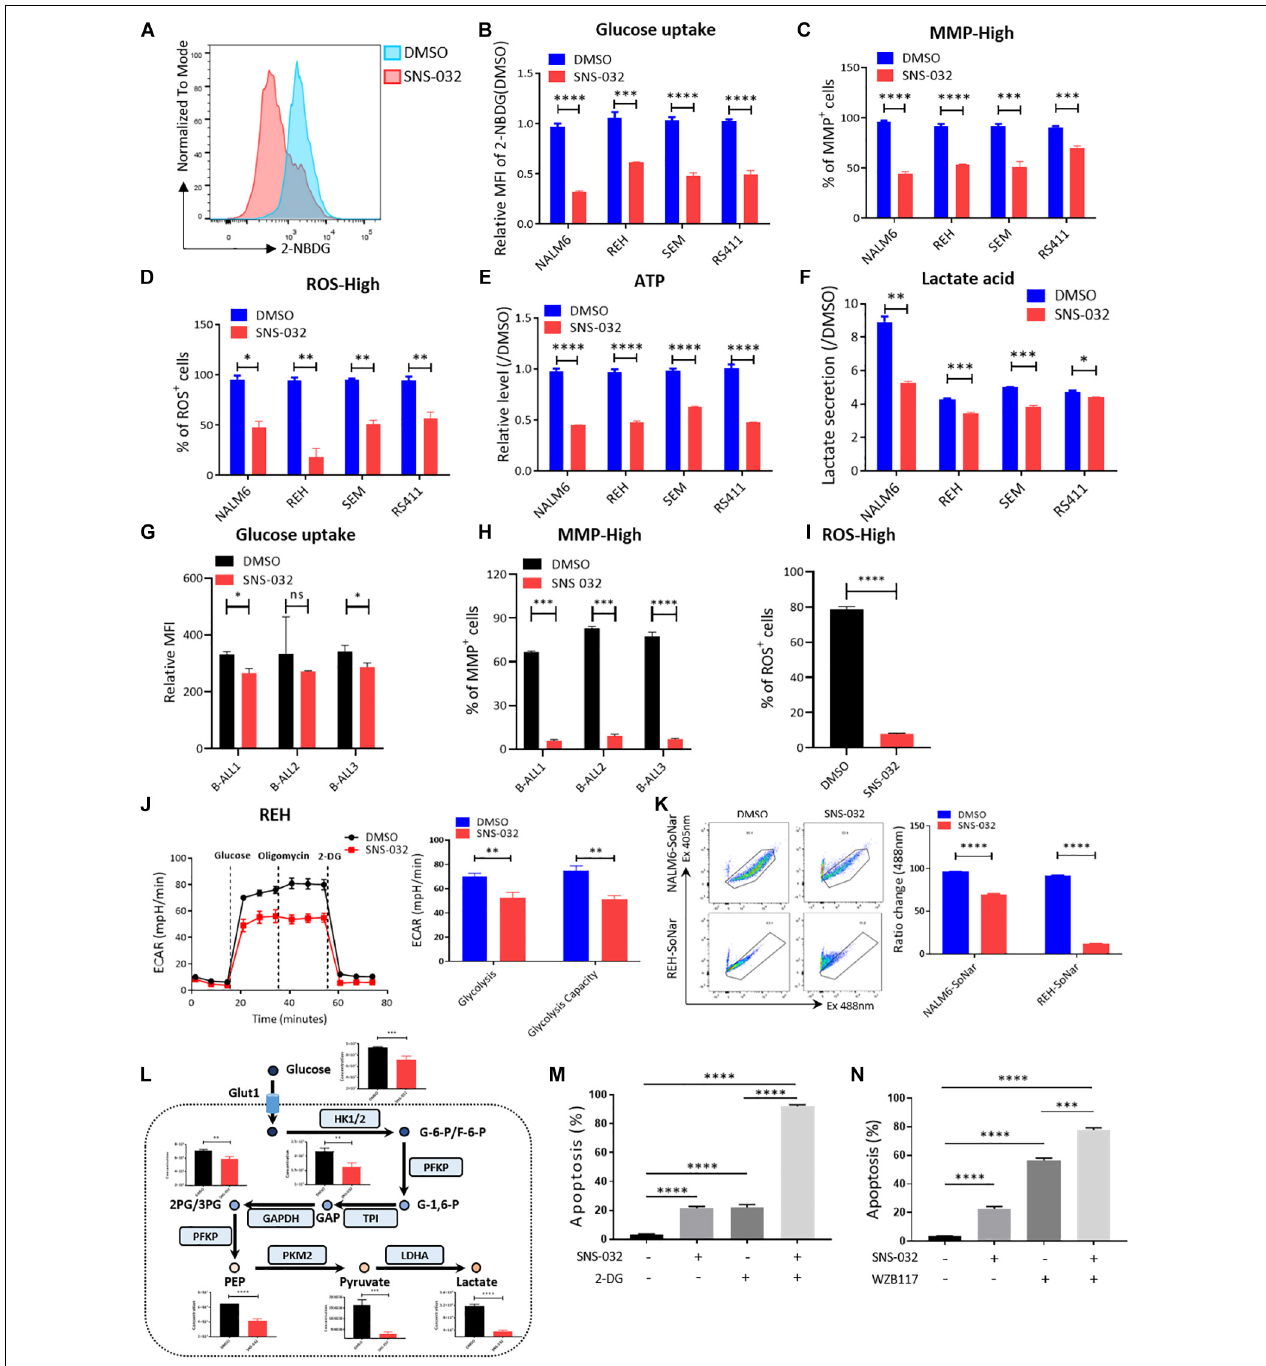
FIGURE 3 | SNS-032 treatment downregulates glucose metabolism in B-ALL cells. (A) The glucose uptake of NALM6, REH, SEM, and RS411 cells was detected by flow cytometry. (B) Statistical analysis of the glucose uptake of B-ALL cell lines. (C,D) The mitochondrial membrane potential (MMP) and total ROS of B-ALL cells were detected by flow cytometry. (E) The quantification of intracellular ATP in B-ALL cells was assessed using the ATP determination kit. (F) Quantification of intracellular lactate in B-ALL cell lines using the lactate assay kit. (G) The glucose uptake of primary B-ALL cells was detected by flow cytometry. (H,I) The MMP and total ROS of primary B-ALL cells were detected by flow cytometry. (J) Detection of ECAR in REH cell using Seahorse XF 96. (K) The SoNar-low or -high cells of B-ALL cells were measured by flow cytometry with 405 and 488 nm excitation. (L) Schematic map of glycolytic metabolism and the metabolic intermediates of glycolysis measured by LC-MS/MS. (M,N) Cell apoptosis of SNS-032-treated REH cells analyzed by flow cytometry after co-treatment with 2-DG (1 mM) and WZB117 (10 nM) for 24 h. Values were shown as mean ± SEM. ∗ p < 0.05, ∗∗ p < 0.01, ∗∗∗ p < 0.001 and ∗∗∗∗ p < 0.0001.